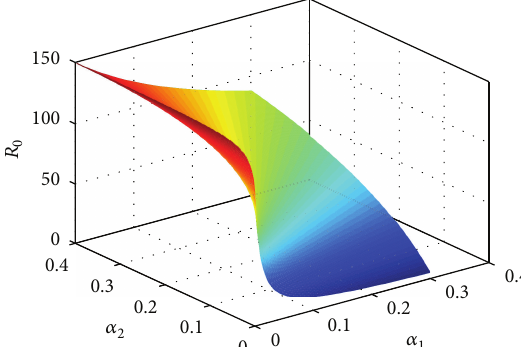
Figure 4: An illustration of the impact of 𝛼 1 and 𝛼 2 on 𝑅 0 .